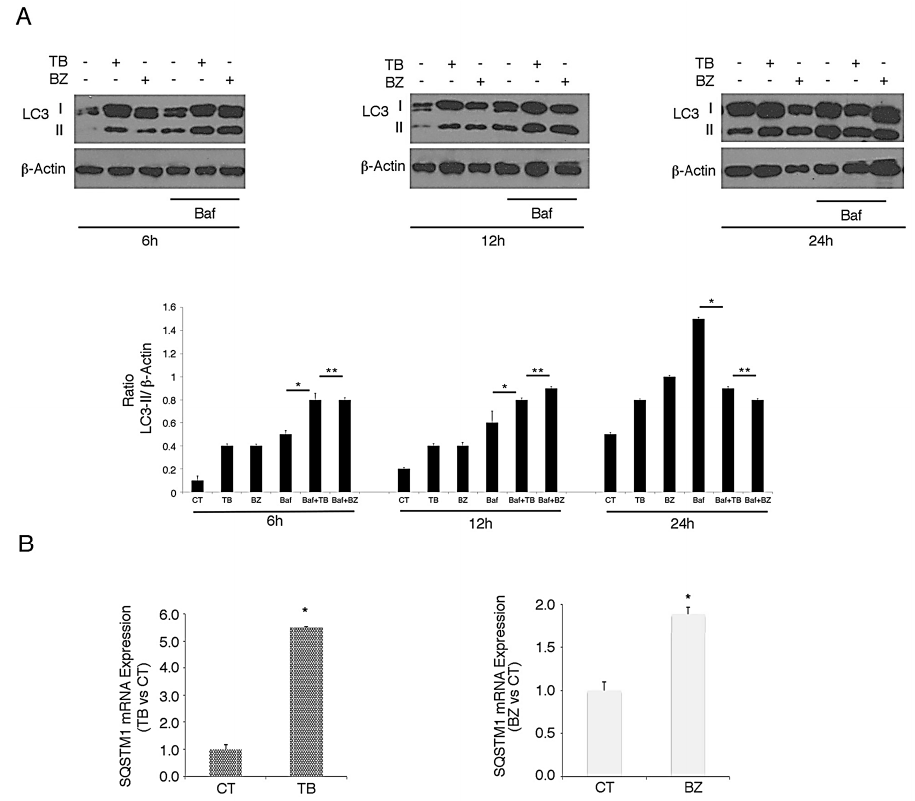
Figure 4. TB and BZ, which activate the KSHV lytic cycle and induce autophagy, increase SQSTM1 RNA in PEL cells. BC3 PEL cells were treated with ( A ) TB or ( B ) BZ in the presence or absence of bafilomycin (BAF) (20 nM) for the final 3 h, and LC3-I/II was evaluated by western blotting analysis.